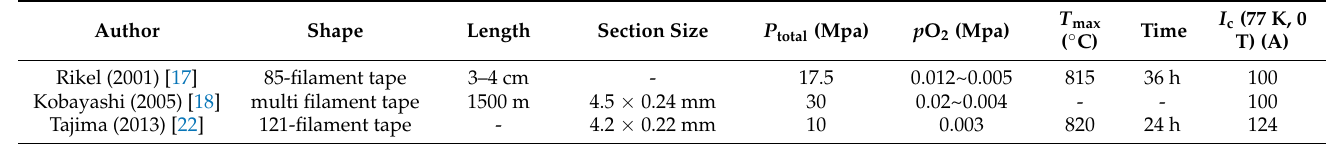
Table 1. Parameters of Bi-2223 tapes fabricated using the overpressure